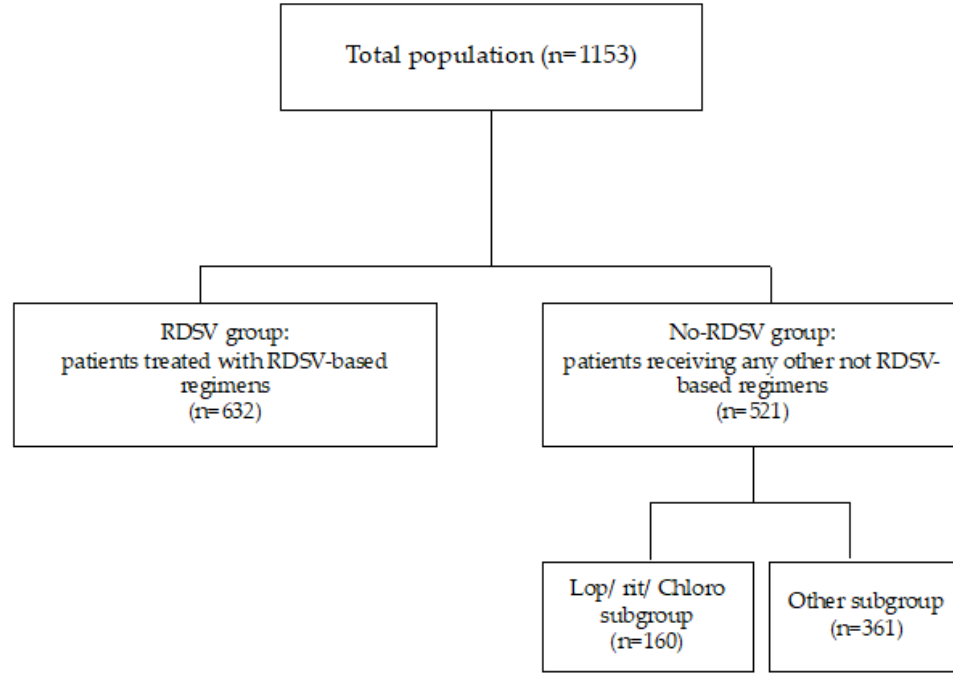
Figure 1. Flow-chart of study